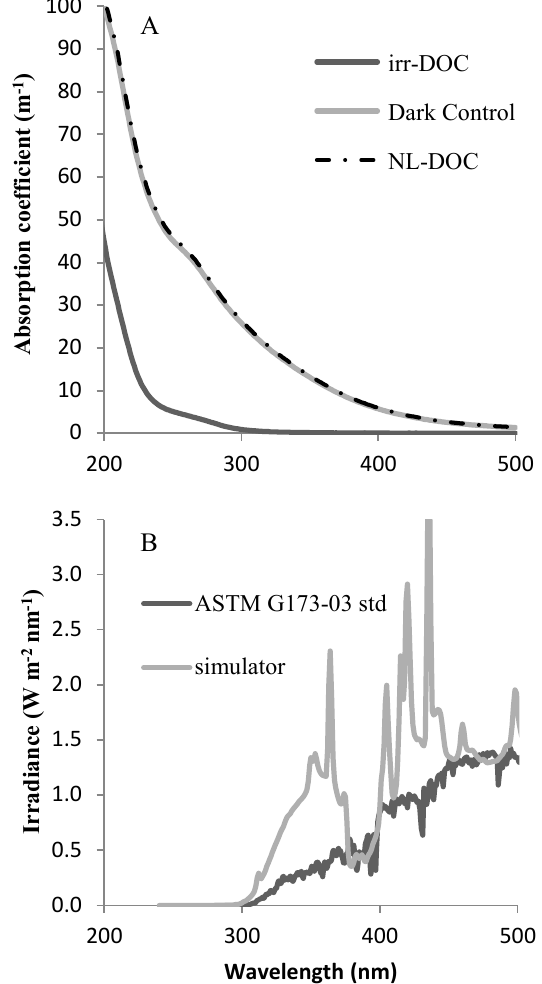
Figure 1. (A) Absorption coefficients of chromophoric dissolved organic matter in the initial NL-DOC, the irradiated DOC (irr-DOC) and the dark control of Amazon River, and (B) the spectral irra- diance of solar simulator (simulator) and natural solar radiation (ASTM G173-03 std; Chu and Liu, 2009). Note that the absorp- tion spectra for NL-DOC and the dark control are almost perfectly superimposed in (A)